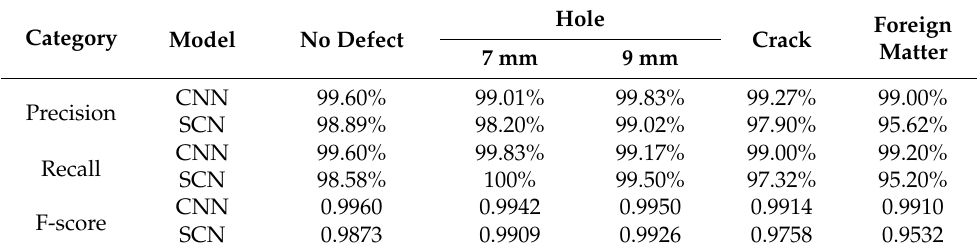
Table 7. Average values of five-classifying model evaluation indices.